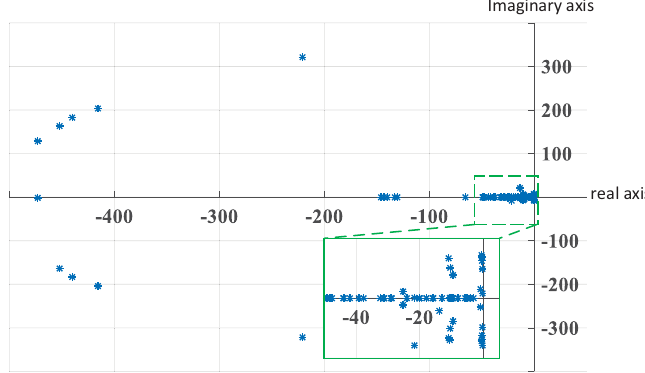
Figure 11. Eigenvalue analysis of IEEE 39-bus test system with high wind turbine penetration (case study